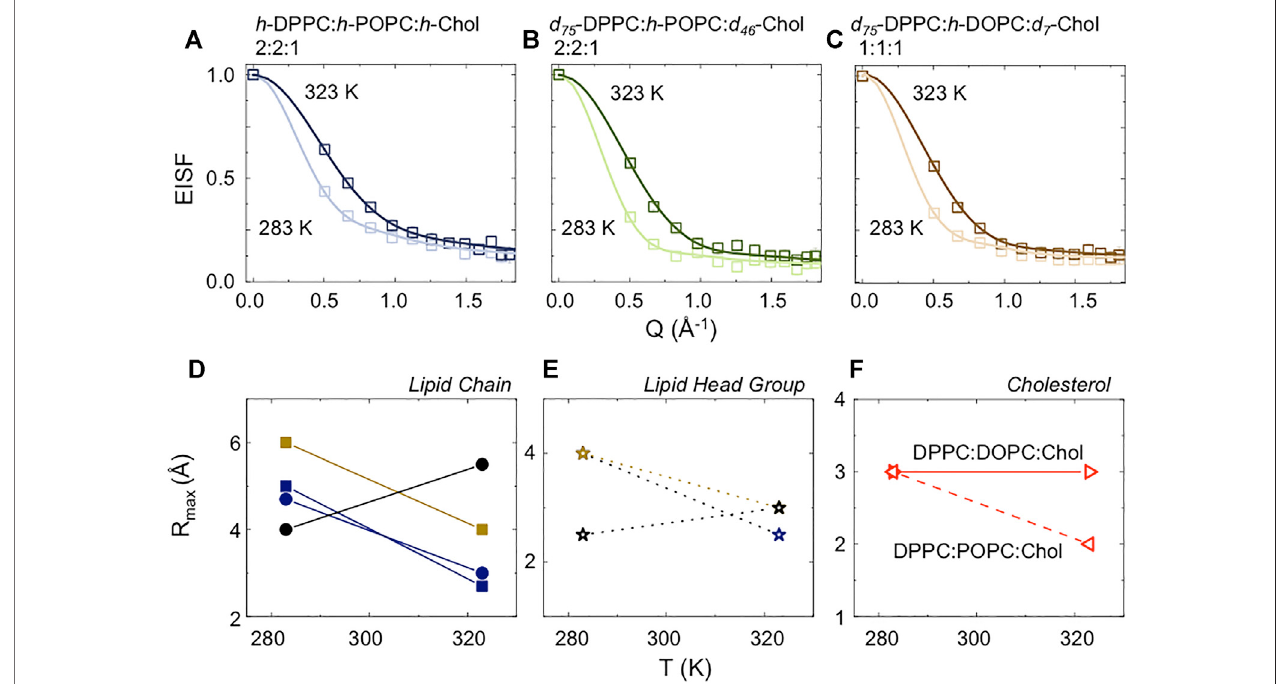
FIGURE 5 | (A – C) EISFs modeled using Eqs 9 , 10 . (D – F) Comparison between the maximum radii of diffusion used to model the EISF. POPC is reported in blue, DOPC in light brown, and DPPC in black. In the bottom panels are reported separately: the comparison between lipid chain (D) ; the comparison between lipid head group (E) , and the comparison between cholesterol in the two systems (F)